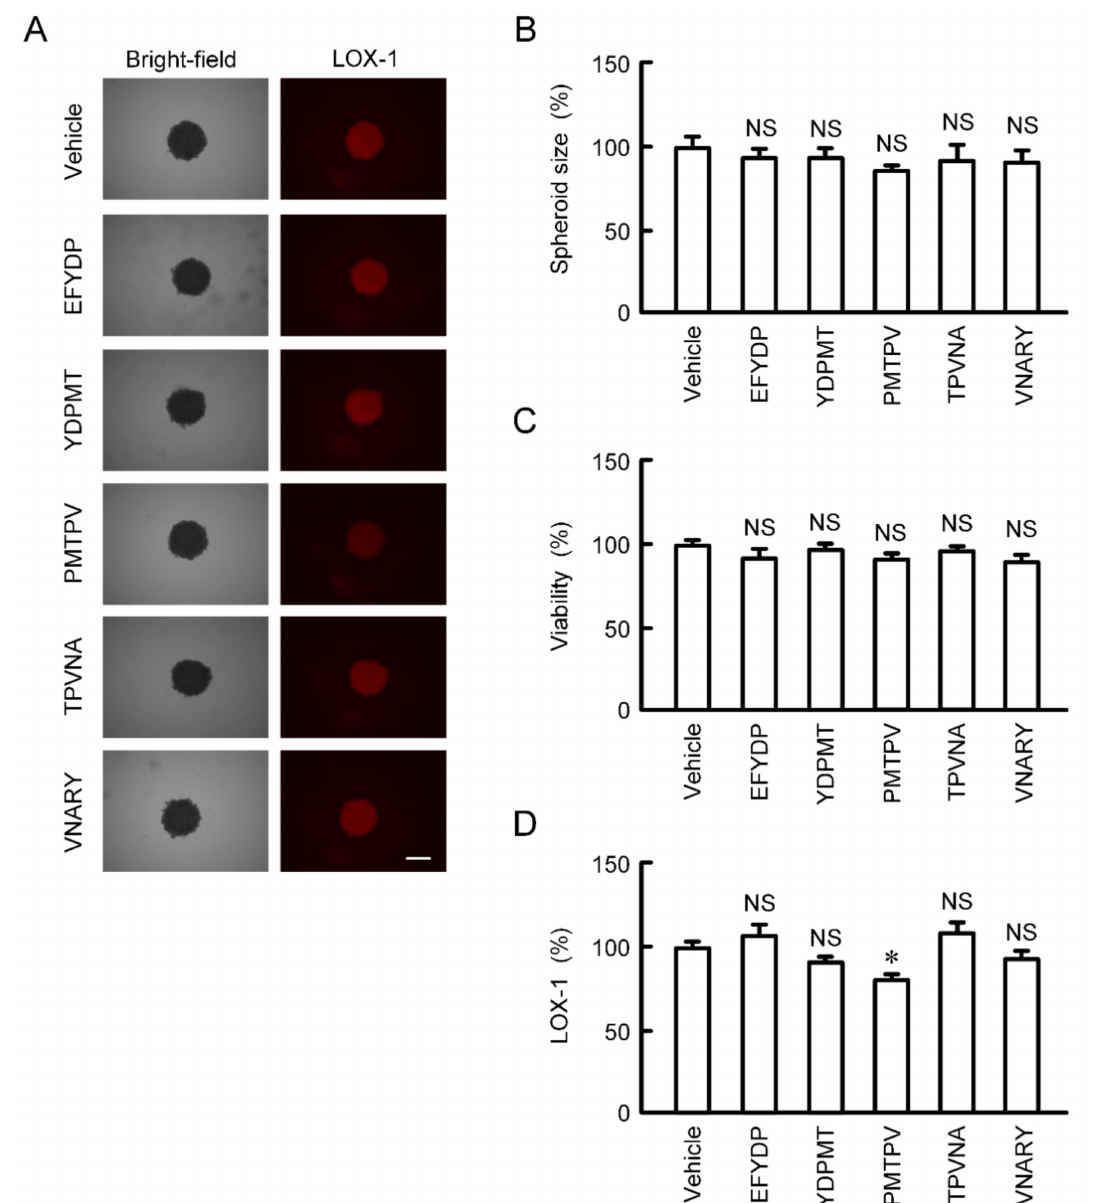
Figure 6. E ff ects of short peptides on cell viability and hypoxic level in 3D culture. A549 cells cultured on PrimeSurface96U multi-well plates were incubated in the presence and absence (vehicle) of each peptide at 100 µ M for 24 h. ( A ) The images of spheroids were collected using a BZ-X800 fluorescence microscope. Representative images of bright-field and LOX-1 are shown. Scale bar indicates 500 µ m. ( B ) The size was calculated using ImageJ and represented relative to the values in vehicle. ( C ) Cell viability was assessed using a CellTiter-Glo 3D Cell Viability Assay kit and represented relative to the values in vehicle. ( D ) Hypoxic level in spheroids was assessed using LOX-1 and represented relative to the values in vehicle. n = 4–6. * p < 0.05 compared with vehicle. NS, p >